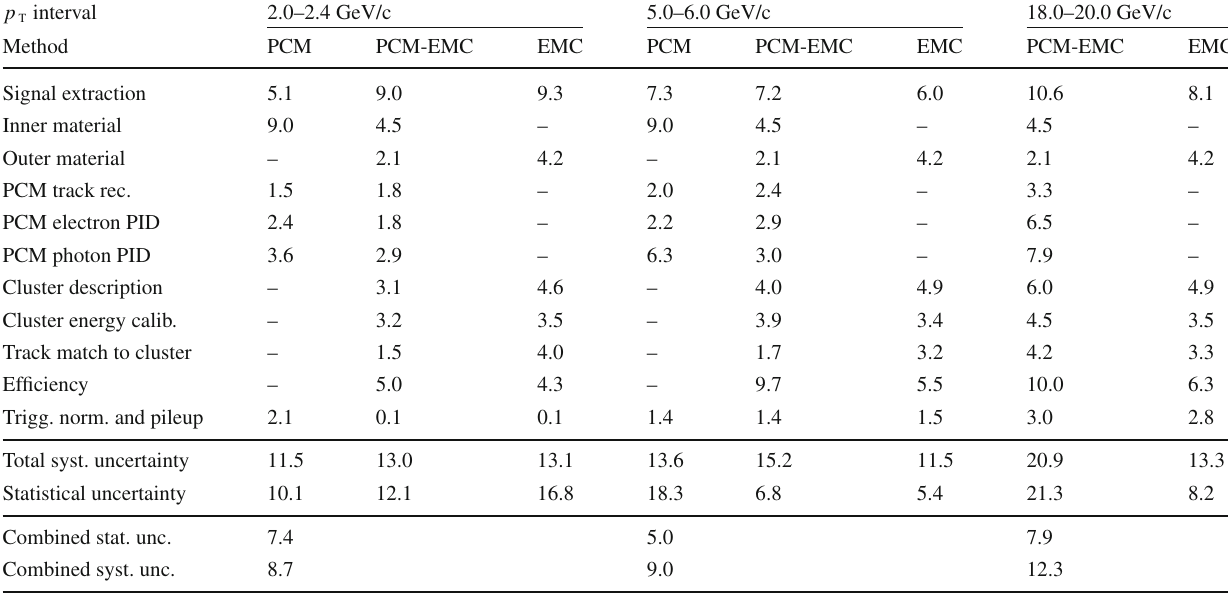
Table 3 Summary of relative systematic uncertainties in percent for selected p explanations which also apply here